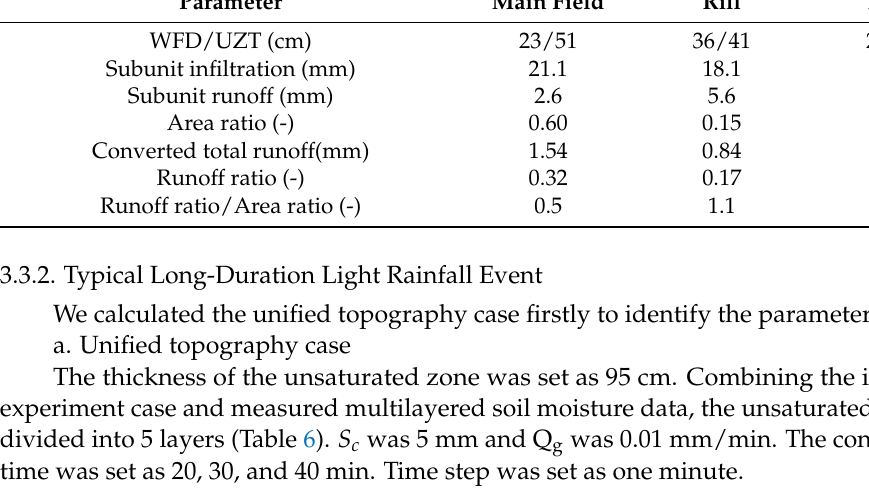
Table 6. Parameters of Layered G–A model for 20160406 rainfall–runoff event. Layer Number Depth (cm) M